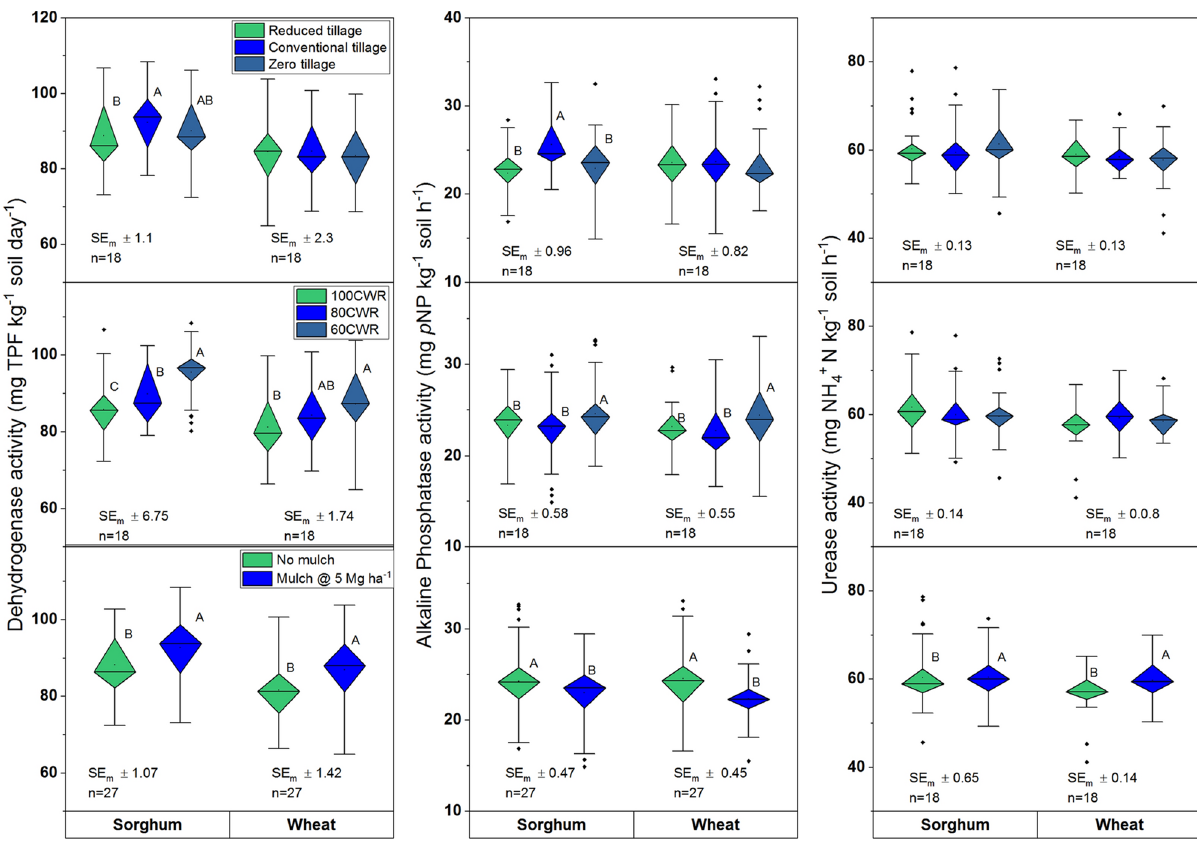
Figure 1. Influence of tillage, irrigation and mulch on microbial biomass carbon, nitrogen and carbon and nitrogen ratio (MBCN) of soils after sorghum and wheat harvest; different uppercase letters (A, B) denote significant differences (** P < 0.01, *** P < 0.001, Tukey’s HSD test). Data are means over 2 years. Irrigation applied only in wheat, sorghum was grown as rainfed; CWR: per cent water requirement for wheat; SE m ± : standard